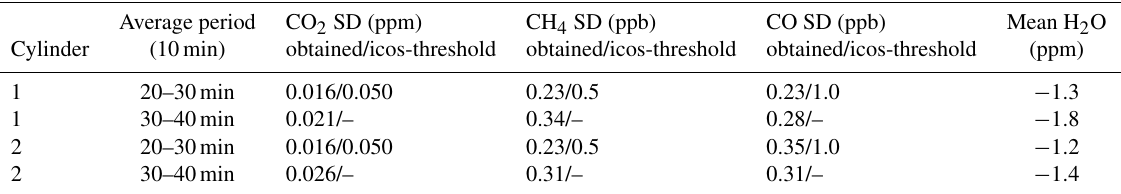
Table 2. Results obtained during the “repeatability test” (LTR) and ICOS-threshold values. The SD reported is of the sample of 10min means obtained through the full duration of the